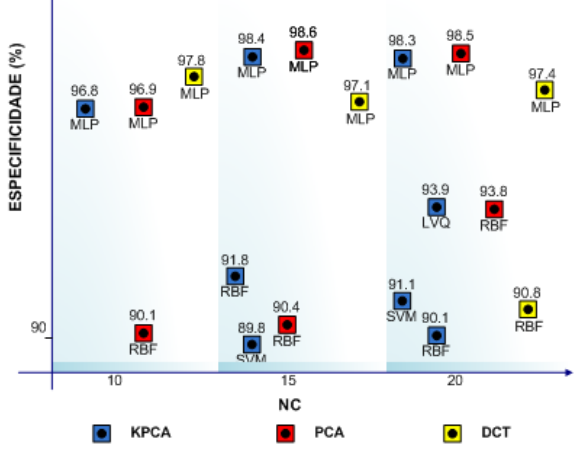
Figura 5. Índice de especificidade para cada classificador. Tabela 1. Todos os classificadores usando